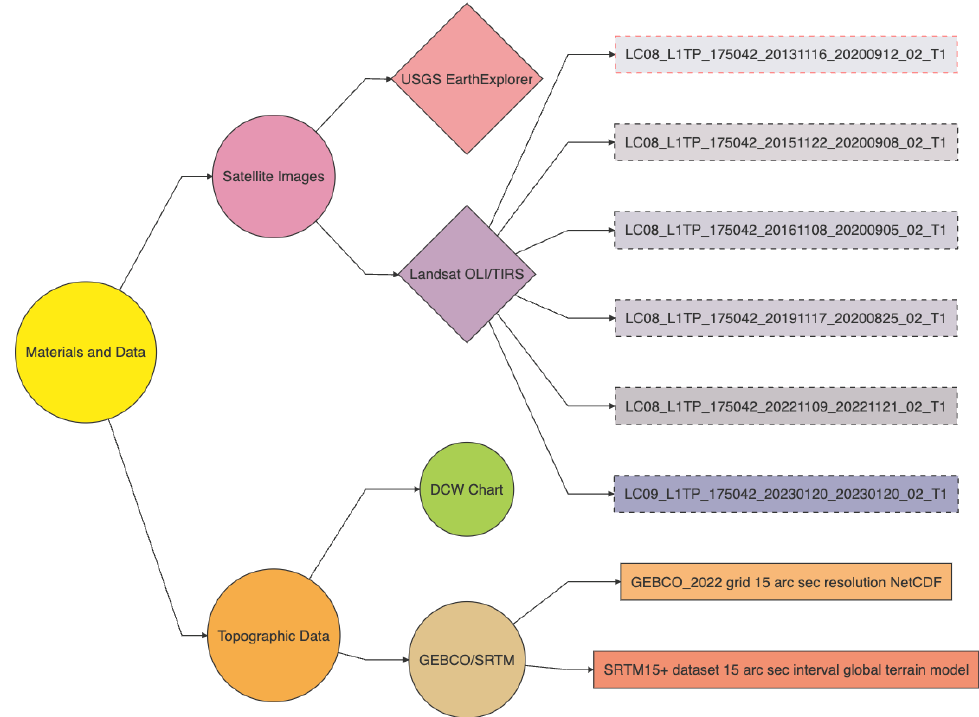
Figure 4. Data sources: summary of the materials used in this study. Software: R version 4.2.2, ‘Mermaid’ library. Flowchart source: